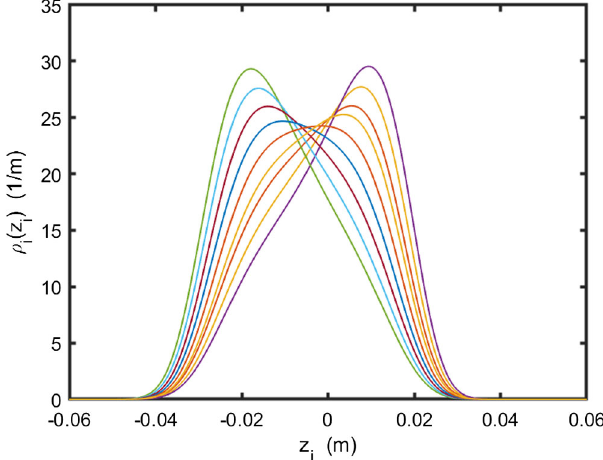
FIG. 6. Bunch length increases in a train of 26, surrounded by gaps of 4 buckets, with main cavity beam loading (blue) and ¼ 496 mA. av ¼ 496 mA. The plot is the ratio of bunch length without (red). I av σ to the natural bunch length σ 0 .